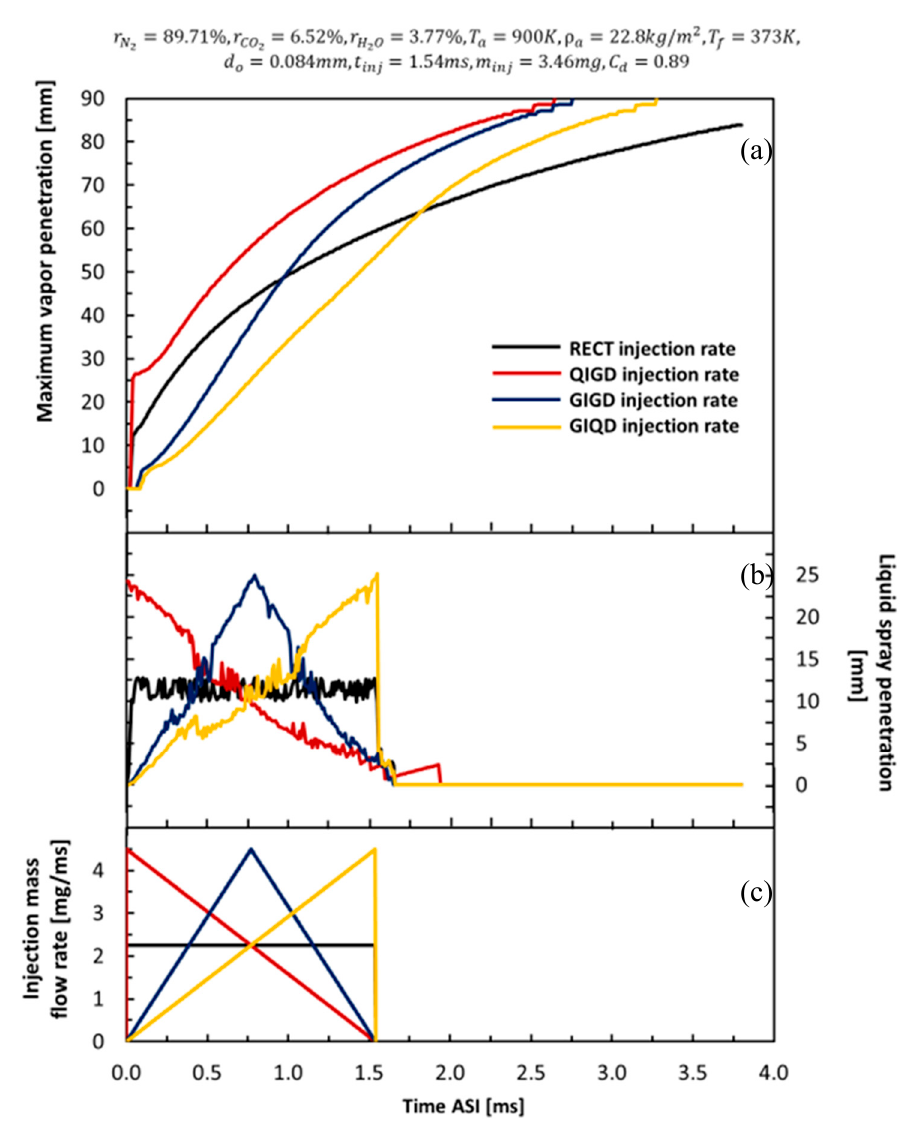
Figure 14. Comparison of the simulated spray penetration with different injection rate shapes. ( a ) Maximum vapor penetration, ( b ) liquid spray penetration and ( c ) injection mass flow rate.